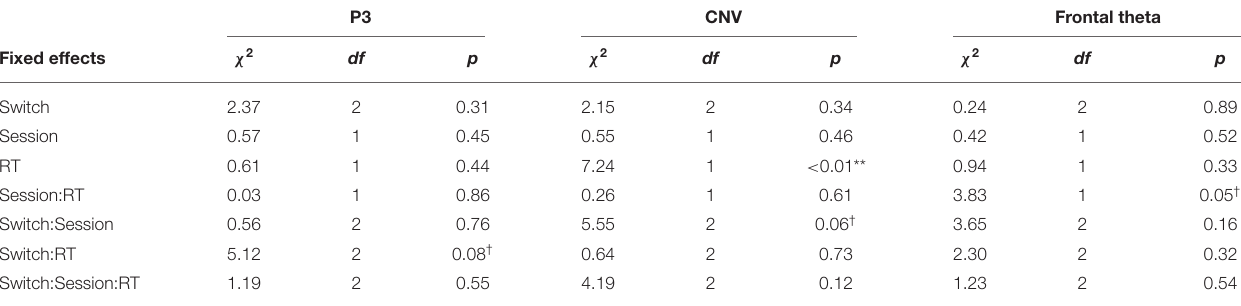
TABLE 5 | Summaries of the Wald χ 2 tests in the LMEs for EEG responses relative to